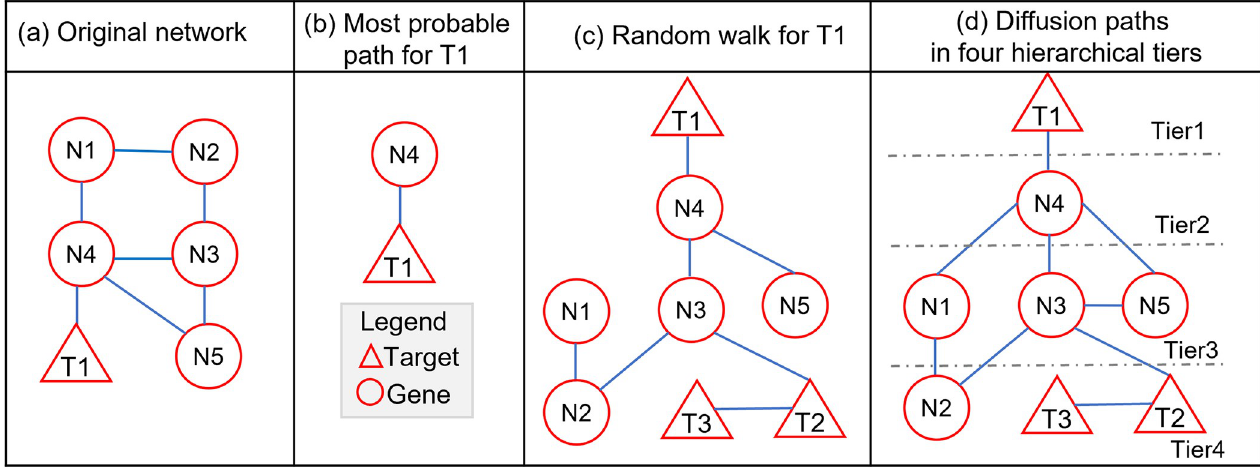
Fig 2. Network configurations for three methods “most probable path”, “random walk” and “diffusion path” are used to calculate target impact score (IS). ( a ) Original network. we use target T1 for example to denote the strategies in ( b )-( d ),( b ) most probable path strategy. ( c ) random walk strategy. ( d ) diffusion path strategy by hierachical tier